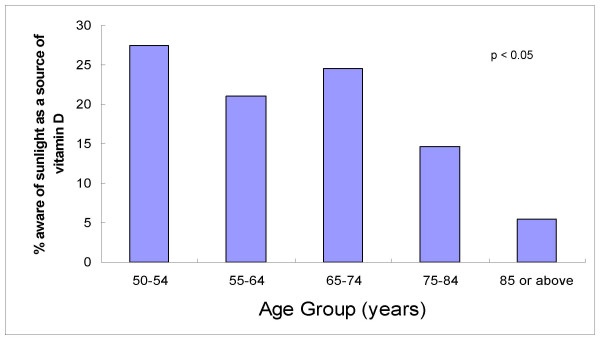
Age stratification of response to the question "Did you know that sun exposure can give you vitamin D?".